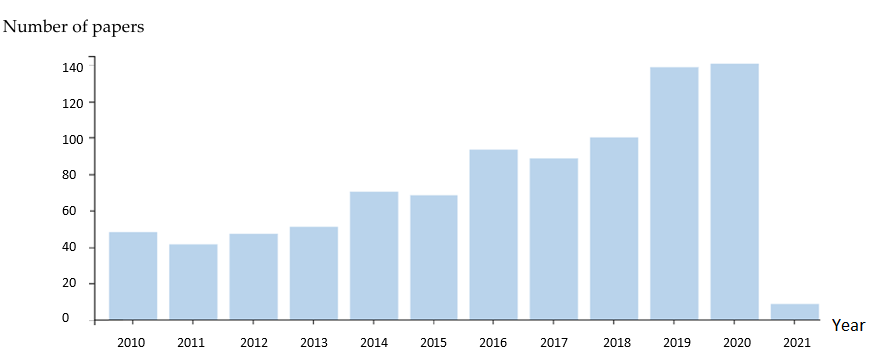
Figure 1. Distribution graph of the number of the articles containing essential oils (EOs) and a livestock animal or an animal food product according to the year of publication (2010–2021).